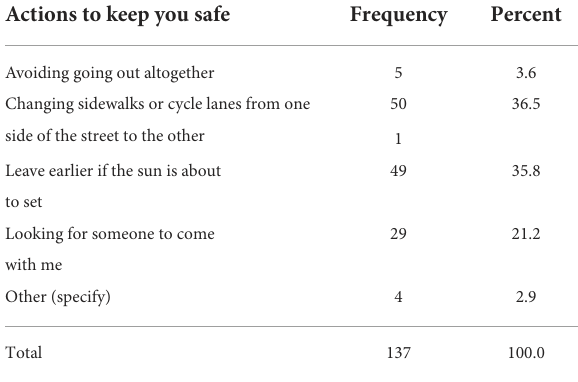
TABLE 6 Safety while walking or cycling. Feeling safe walking or cycling